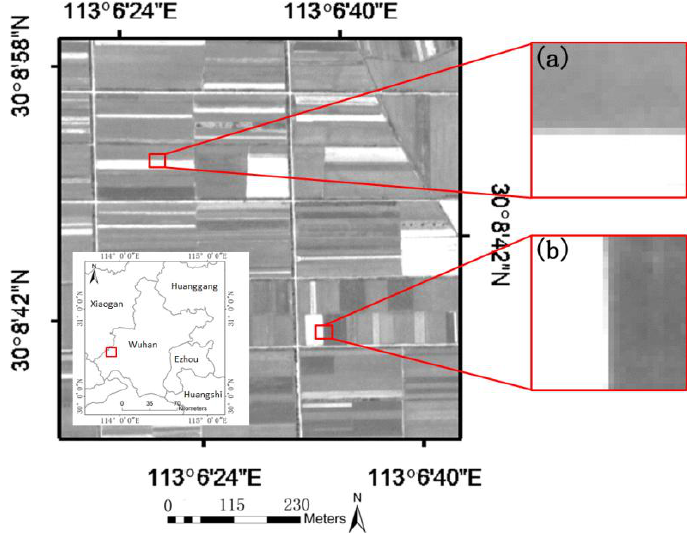
Figure 2. Two samples in the image of the agriculture area of Wuhan, HB, for edge extraction. The two edges are the common borders between different fields. ( a ) Edge extracted for edge response (ER)x. ( b ) Edge extracted for